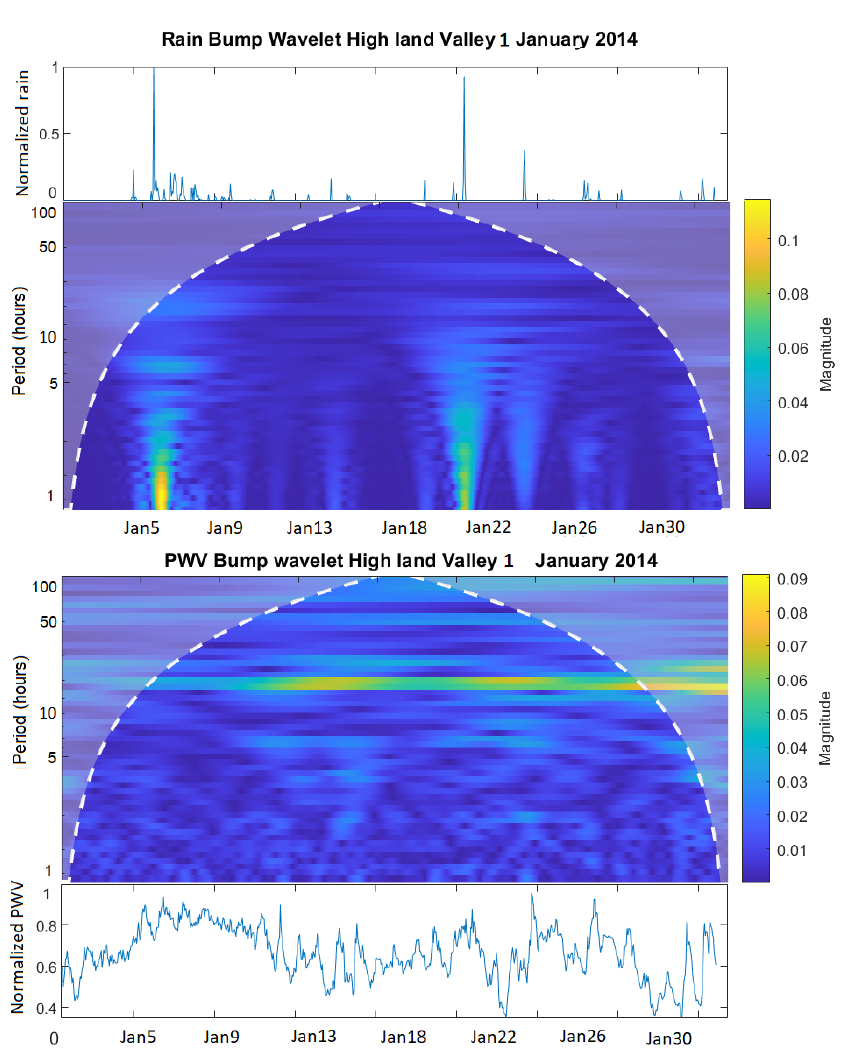
Figure 5. Zoom-in of the continuous wavelet plot of the Andes valley station 1 (Quito) for the rain ( top ) and PWV ( bottom ) for January 2014 with their respective time series.